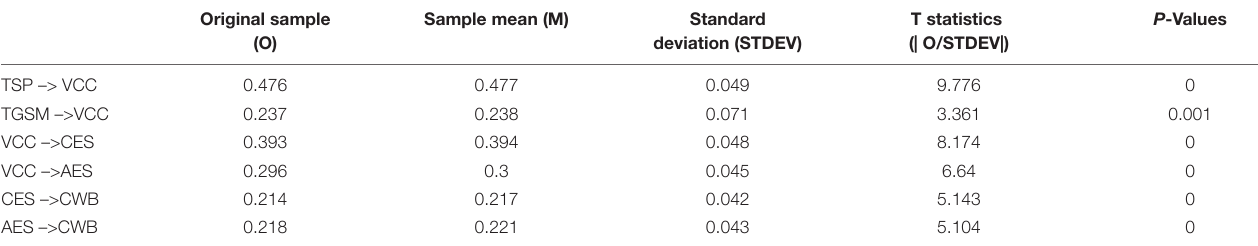
TABLE 6 | Path coefficients of the proposed model.